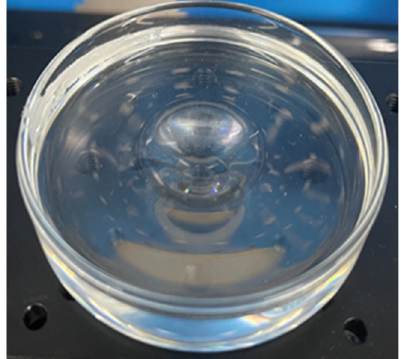
Figure 1. The stable interface.